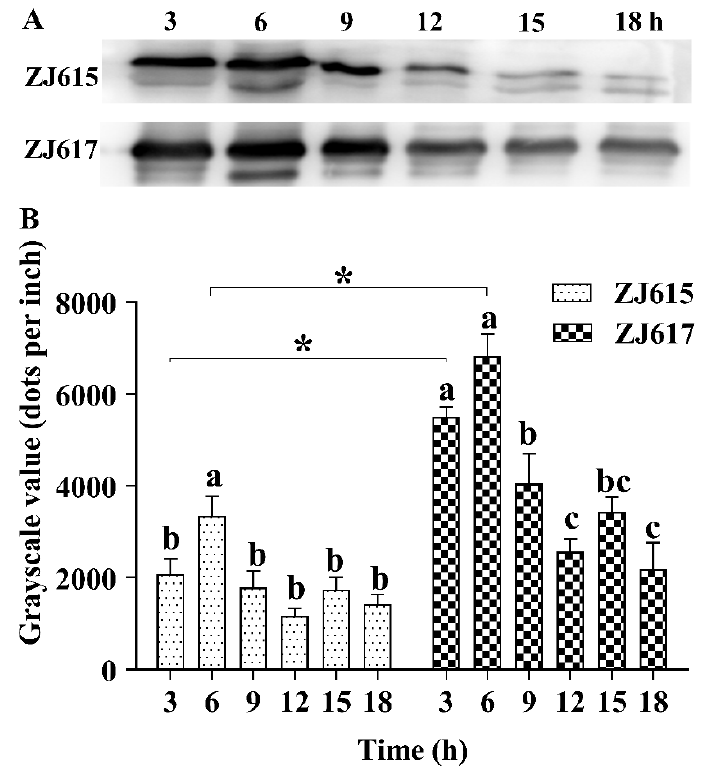
Figure 1. Immunoblot analysis of glyceraldehyde-3-phosphate dehydrogenase (GAPDH) on the surface of L. reuteri ZJ617 and ZJ615. Surface proteins were extracted, separated by dodecyl sulfate, sodium salt–polyacrylamide gel electrophoresis (SDS–PAGE) and transferred to a polyvinylidene fluoride (PVDF) membrane, which was then probed with a rabbit anti-GAPDH antibody. ( A ) Surface GAPDH proteins from L. reuteri ZJ617 and ZJ615. ( B ) Quantification of protein bands from the immunoblotting at different time points. Data are presented as mean + SD ( n = 5). A one-way ANOVA with Duncan’s multiple range test was used. Different letters indicate significant differences within each strain ( p < 0.05). Asterisks indicate significant differences between the two strains ( p < 0.05).